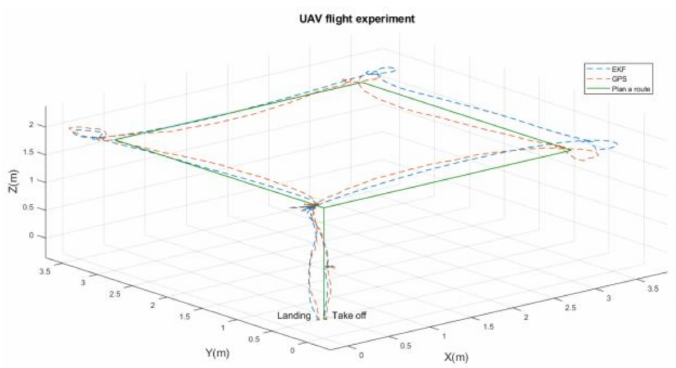
Figure 15. The experimentally autonomous rectangular flight.